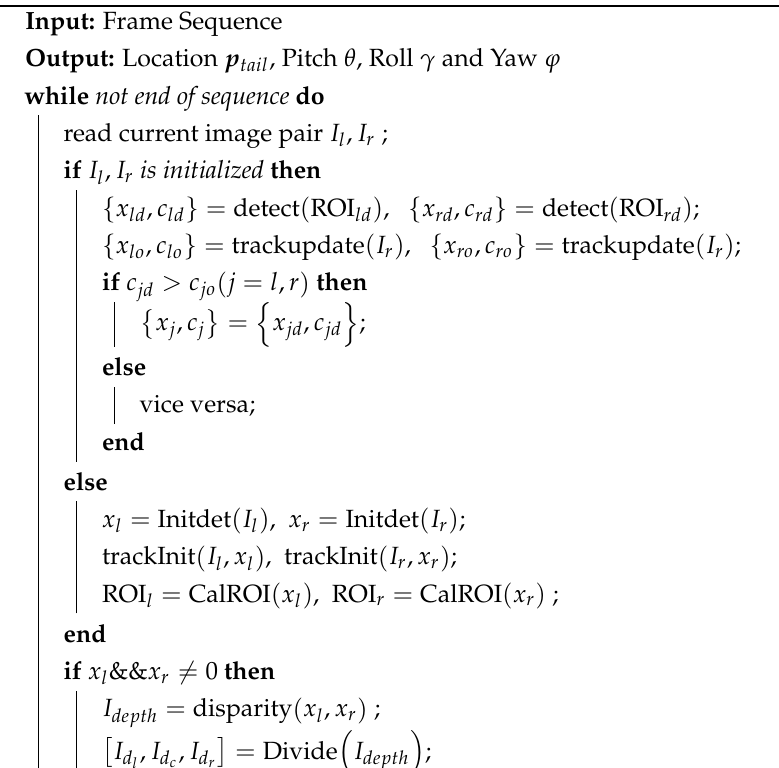
Algorithm 1: Measuring Position and Orientation of